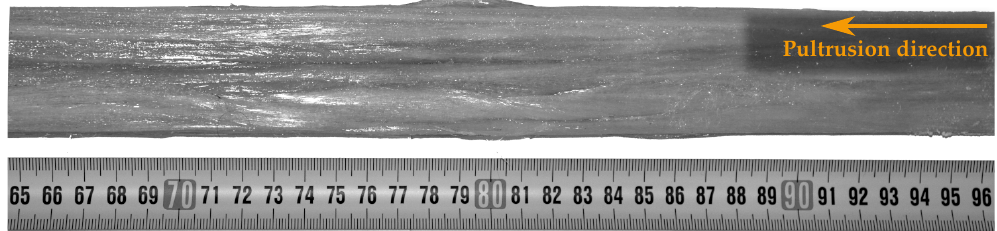
Figure 8. Material at 80cm with thickening as a result of insufficient polymer